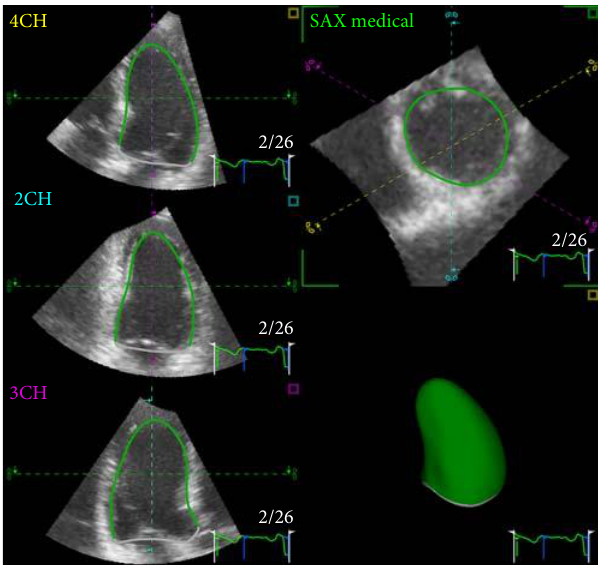
Figure 9: Surface rendering display of left ventricular volume. After having identified the endocardial border on the 3 apical slices, the software automatically detects the whole endocardial surface. The accuracy of endocardial border detection on the whole left ventricular circumference can be checked on the transverse slice which can be moved up and down along the left ventricular long axis. Once confirmed by the operator, a 3D cast of the left ventricle is developedandthevolumeismeasuredbycountingthevoxelswithin the volume.